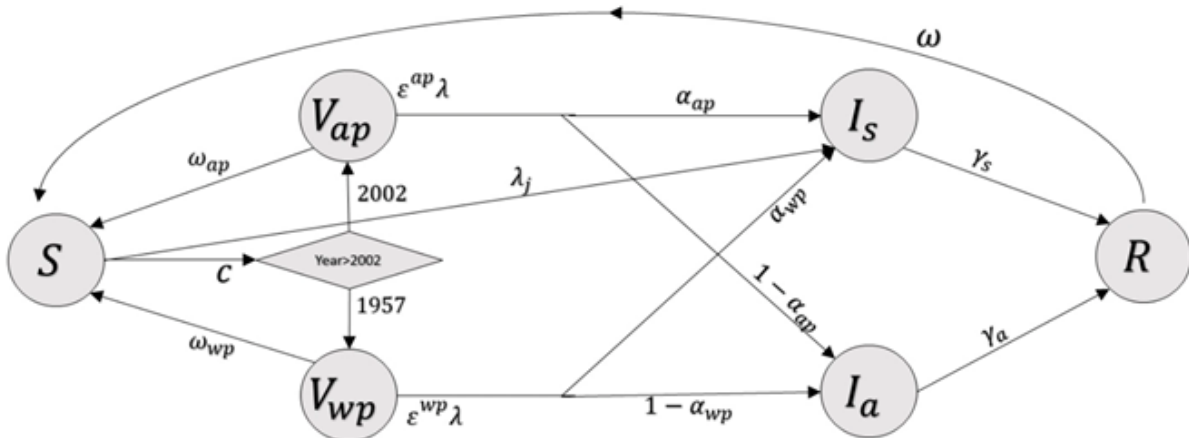
Figure 1. Compartmental diagram of the transmission model. Individuals are born in a susceptible compartment S , where they can become symptomatically infected I s . Following infection, individuals transition to a recovered compartment R , where they are temporarily immune. Following immunity waning, individuals return to S . Depending on the year and their age, individuals are vaccinated with a whole-cell vaccine, V wp , or an acellular vaccine, V ap . Vaccinated individuals are at a reduced risk of becoming infected, and if infected can be either symptomatic, I s , or asymptomatic, I a . For clarity, age stratification is not shown in the figure.